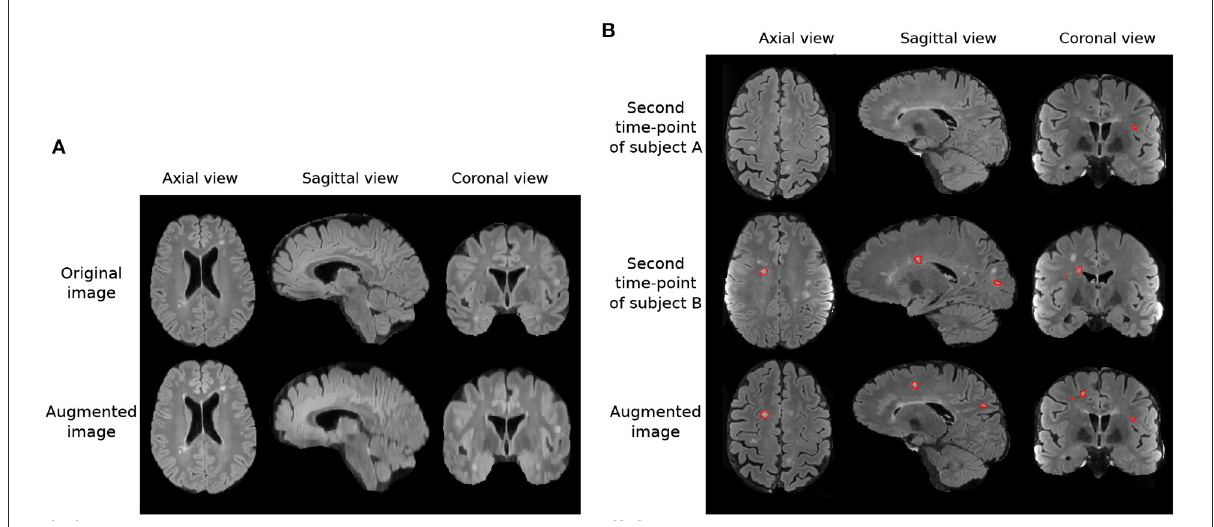
FIGURE3 Imaging and lesion-aware data augmentations applied on the MSSEG-2 training set. (A) Example of axial subsampling ( n = 4) to simulate the blurring in image acquisition. (B) Example of the CarveMix augmentation. Lesions from subject B are carved out and fused onto scan from subject A. Contours delineate lesion